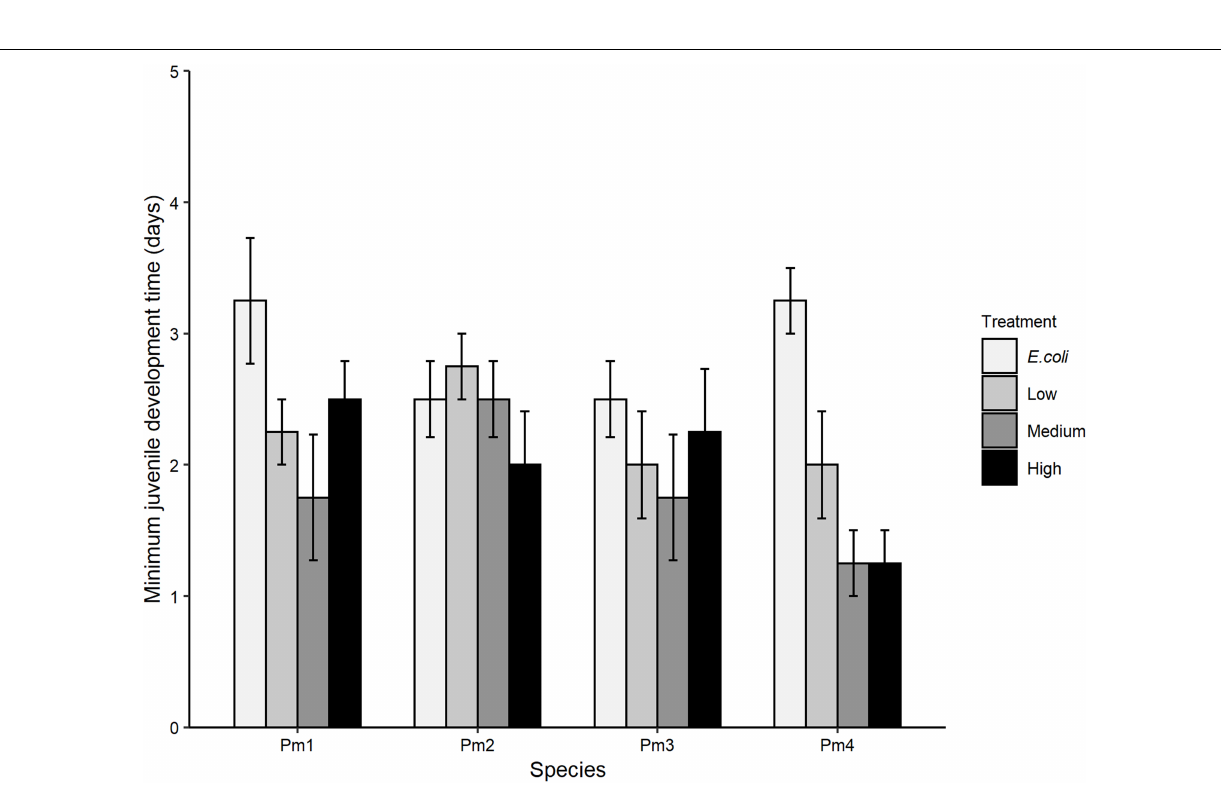
Frontiers in Marine Science |